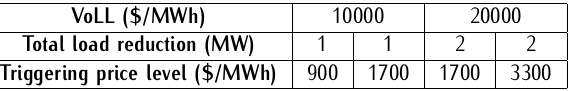
Table 9. Triggering non-responsive price